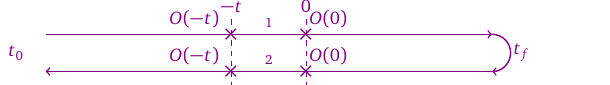
Figure 5: Contour-ordered correlator for 〈 O ( − t ) O ( 0 ) O ( 0 ) O ( − t ) 〉 where t >